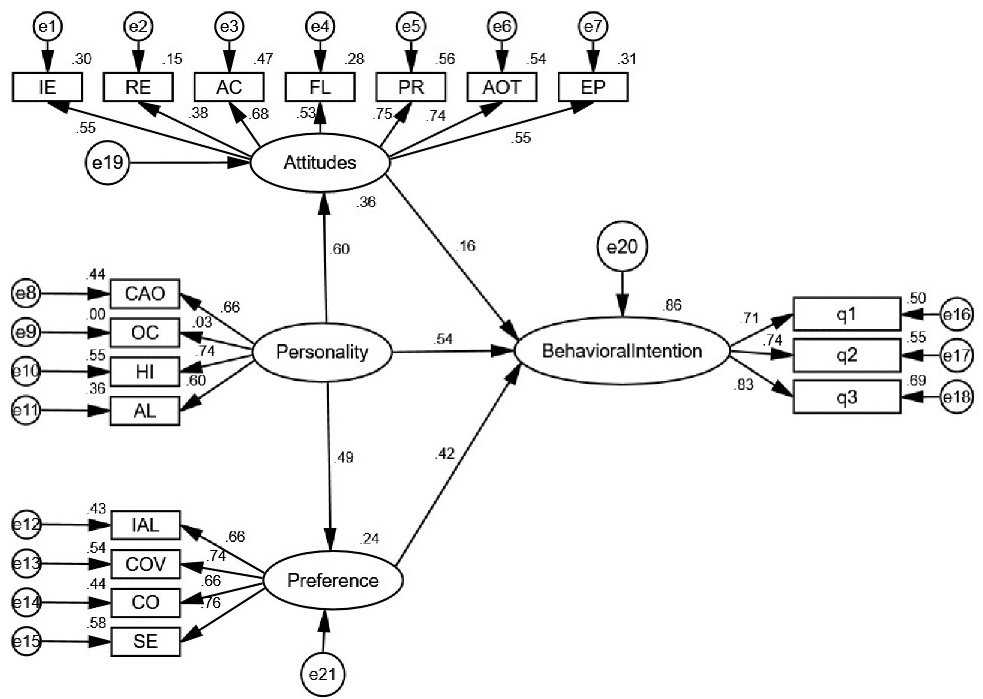
Fig 2. Structural equation diagram for analysis of intention to use